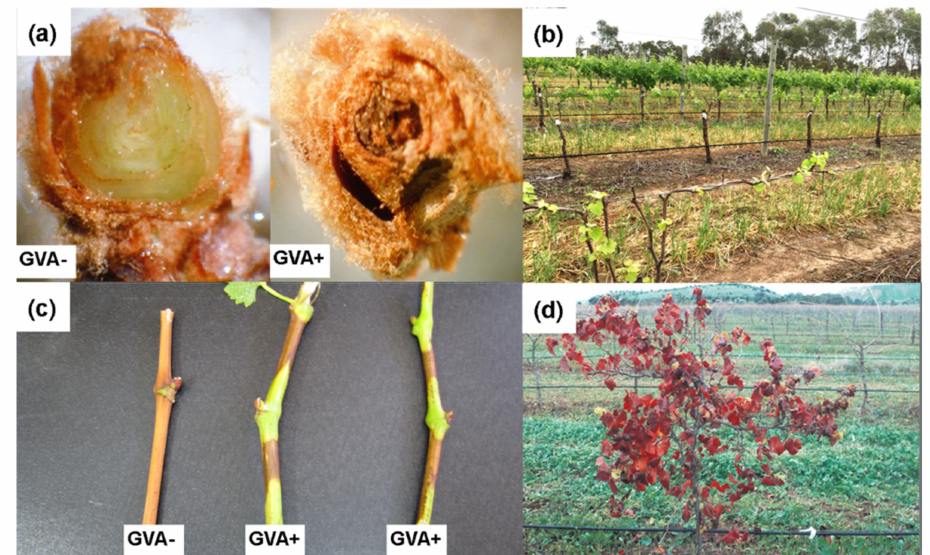
Figure 1. Symptomatology of grapevine virus A (GVA)-associated Shiraz Disease. ( a ) primary bud necrosis shown on right; ( b ) restricted spring growth (front row); ( c ) partial lignification showing islands of green immature canes; ( d ) retention of crimson coloured leaves on canopy in